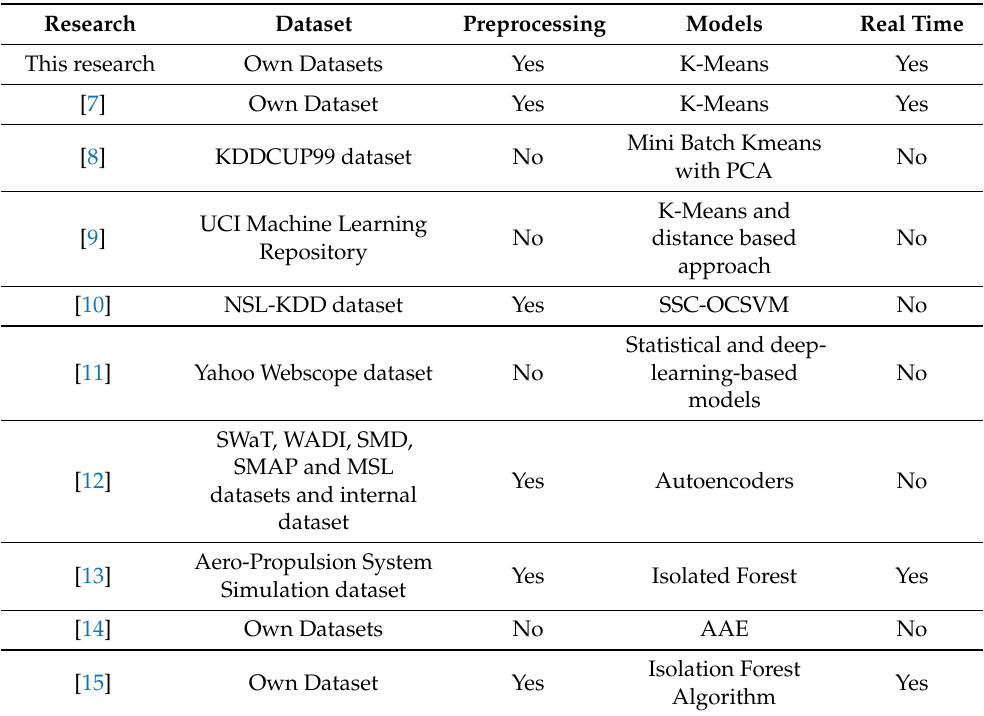
Table 5. Results obtained in previous